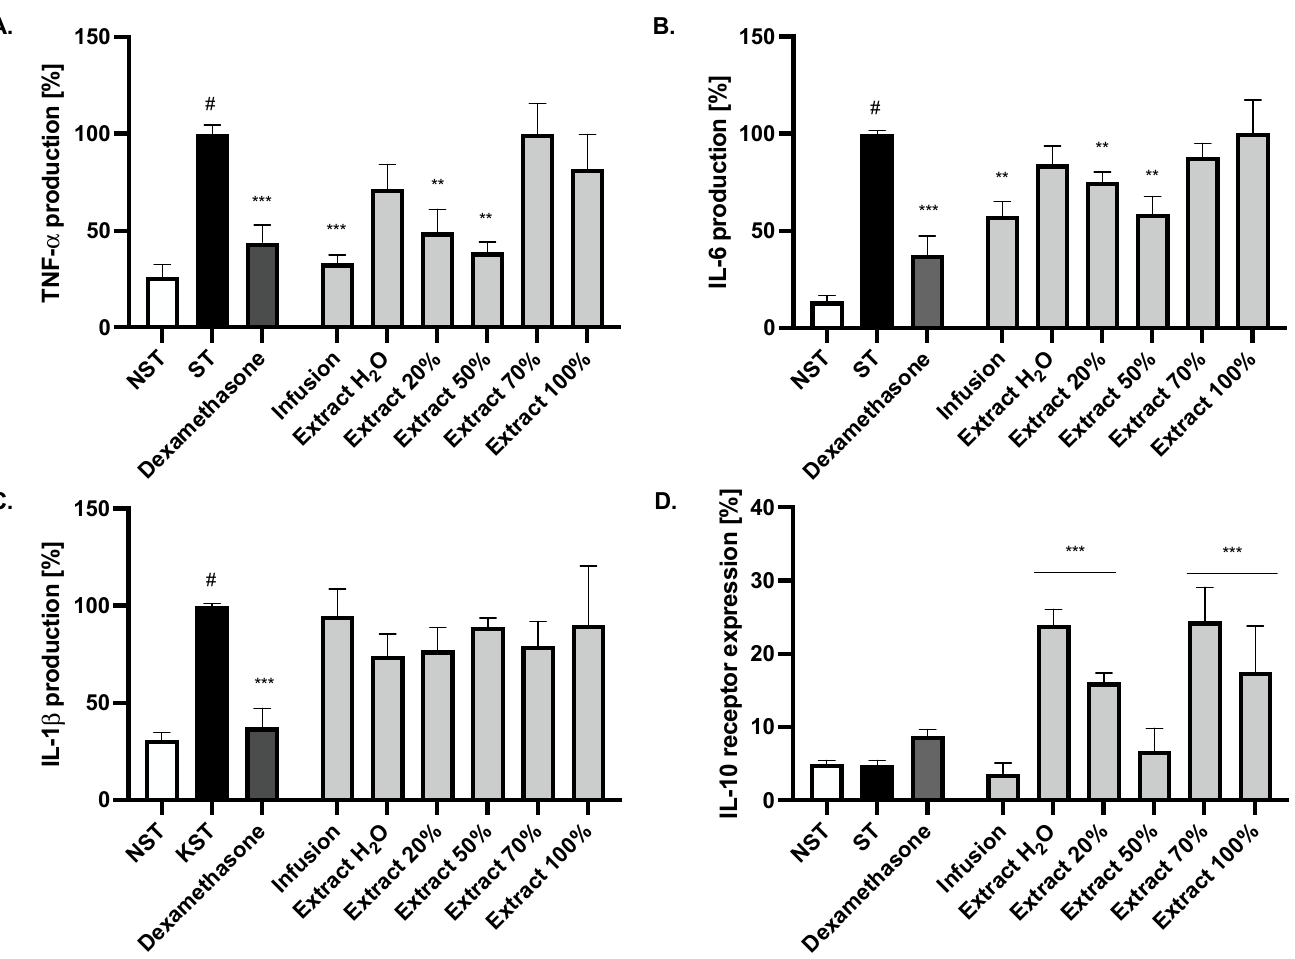
Figure 2. The influence of infusion and selected extracts on ( A ) TNF- α , ( B ) IL-6, ( C ) IL-1 β secretion and ( D ) IL-10 receptor expression by LPS-stimulated monocytes/macrophages. Non-stimulated cells (NST), LPS-stimulated (ST) monocytes/macrophages and LPS-stimulated monocytes/macrophages treated with 50 μ g/mL of infusion or selected extracts. Dexamethasone (20 μ M) was used as a positive control. Data are expressed as mean ± SEM (three separate experiments performed on monocytes/macrophages isolated from independent donors). Statistical significance: ** p < 0.01, *** p < 0.001 versus stimulated control, # statistically significant ( p < 0.001) versus non-stimulated control. Moreover, fractions from Extract 20% were also analysed for their ability to in- duce IL-10 receptor expression, and interestingly in this case, fractions F1_20%, F5_20% and F6_20% were active, suggesting that different compounds are responsible for the pleiotropic anti-inflammatory activity of ash leaves (Figure 4). Fraction F1_20% did not contain any secondary metabolites and probably may contain some polysaccharides, while F5_20% and F6_20% were enriched by secoiridoids, oleuropein and ligtroside, and a phenylethanoid esterified with an oleoside 11-methyl ester was tentatively identified as oleoacteoside (tr = 39.9 min; pseudomolecular ion [M-H] − at m / z 1009 and fragment ions at m / z 847 [M-H-162] − , m / z 623 [M-H-162-224] − and m / z 461 [M-H-162-224-162] − , corre- sponding to the cleavage of hexose, elenolic acid and caffeoyl moieties). From the fractions F3_20% and F5_20%, using Sephadex LH-20 chromatography and preparative chromatography, three compounds were isolated (Figure 5). Their structures were confirmed by 1H and 13C NMR spectra by comparison with reference data